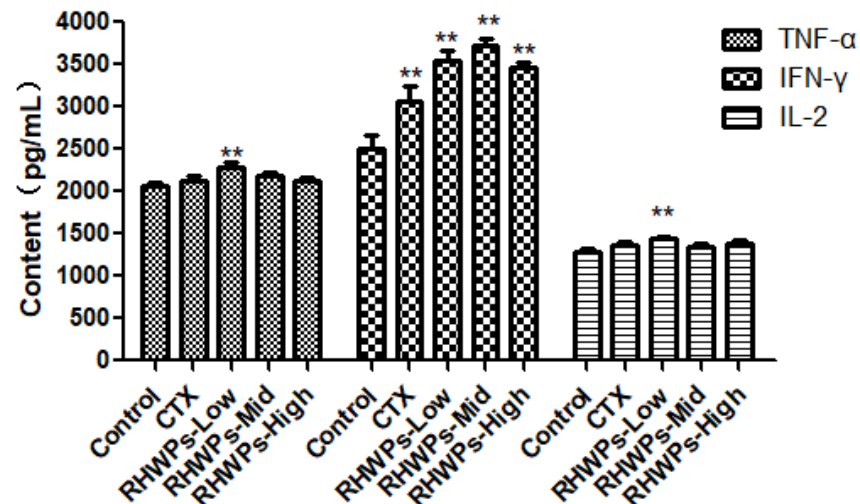
Figure 7. TNF-α, IFN-γ, and IL-2 levels in the sera of the mice. The concentration of TNF-α, IL-2, and IFN-γ in serum of ICR mice was determined by ELISA kit. Data are means ± SD ( n = 10). Sig- nificant differences from the control groups are designated as ** p < 0.01.